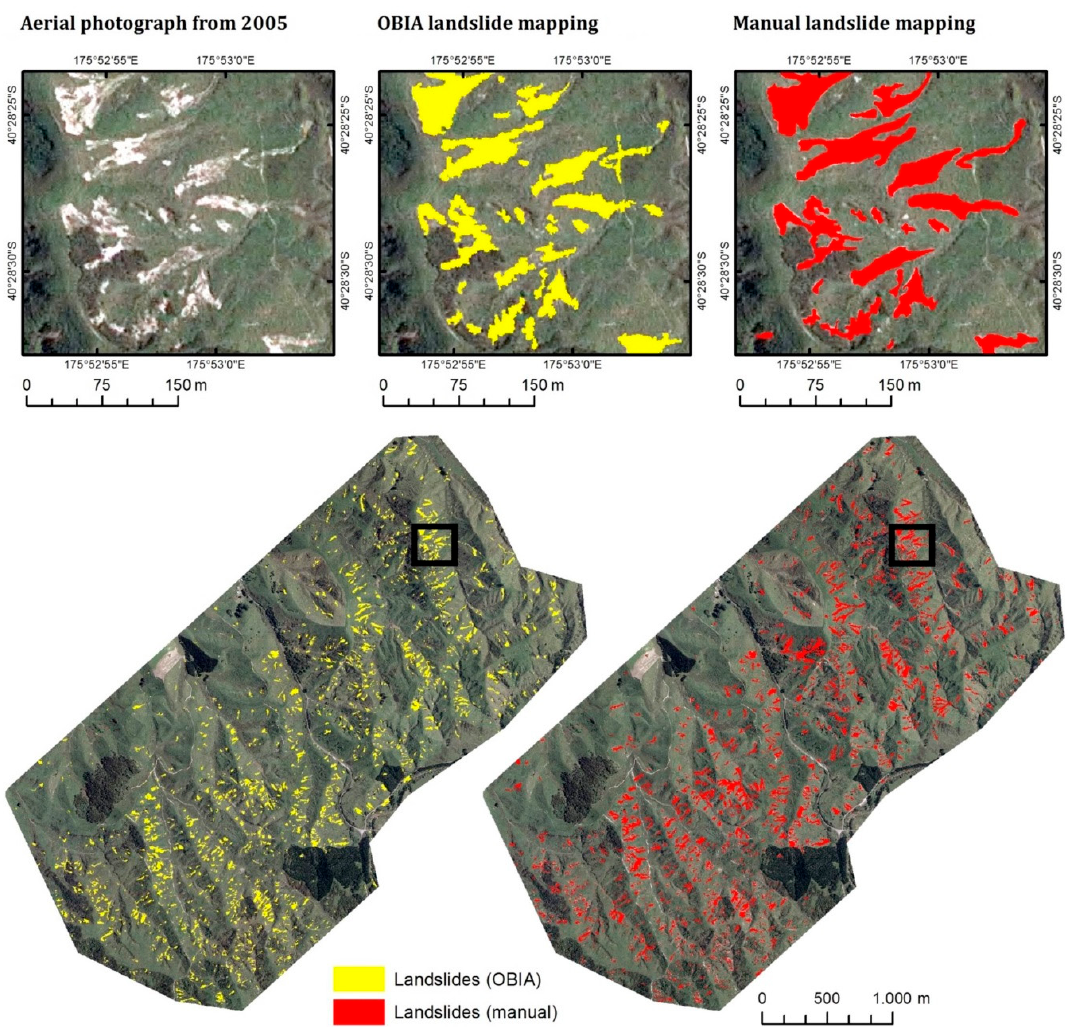
Figure 4. Semi-automatically mapped landslides using the object-based image analysis (OBIA) approach (in yellow color) and manually mapped landslides (in red color) for the aerial photograph from 2005 for the whole study area (below). The results show that, apart from the northeastern part, the study area is heavily affected by landslides. A subset showing the two mapping results for a couple of landslides is shown above. The black rectangular indicates the location of the subset.